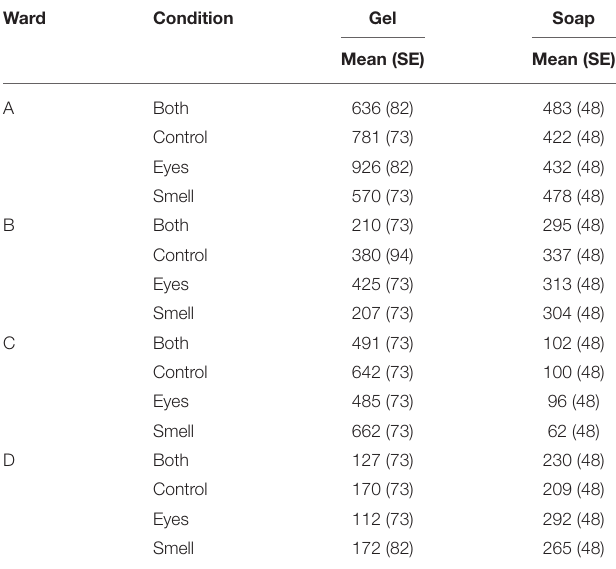
TABLE 3 | Model means and standard errors (SE) for gel and soap material-use in grams, broken down by treatment condition and ward. Ward